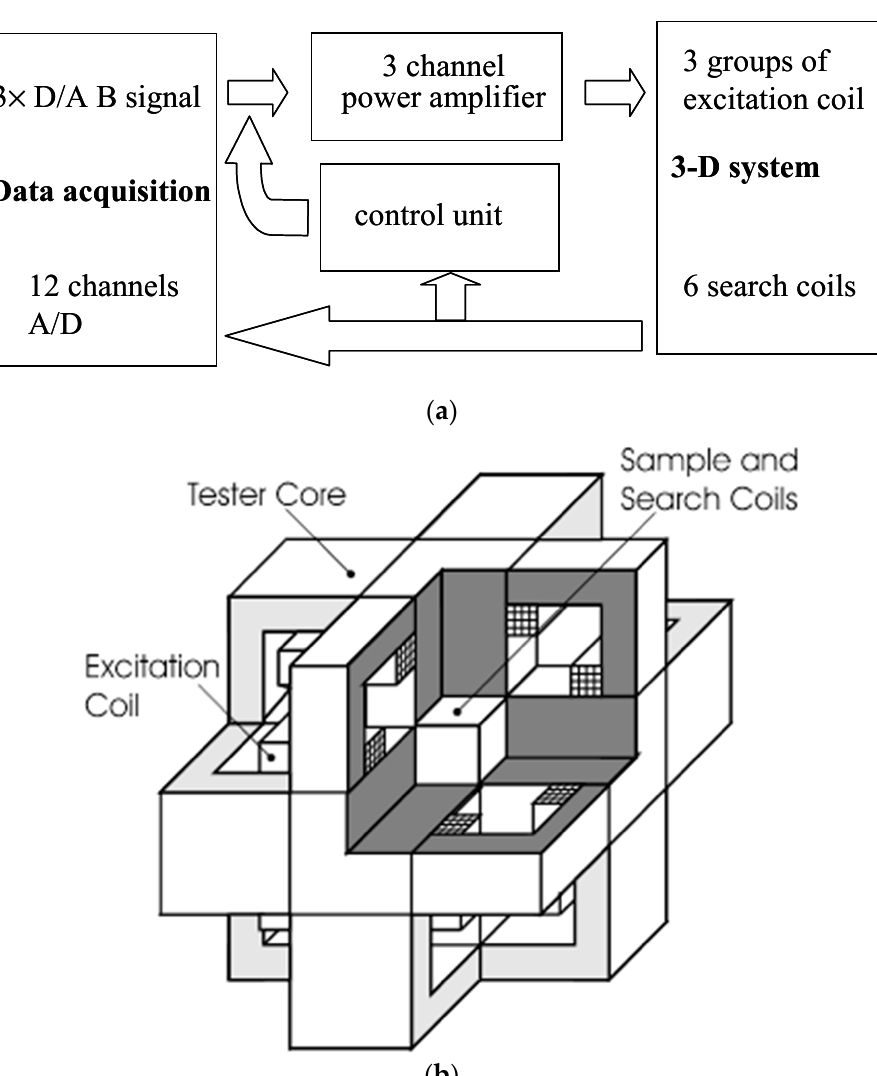
Figure 1. 3D Vectorial Magnetic Property measurement system: ( a ) Block diagram, and ( b ) structure of 3D view.